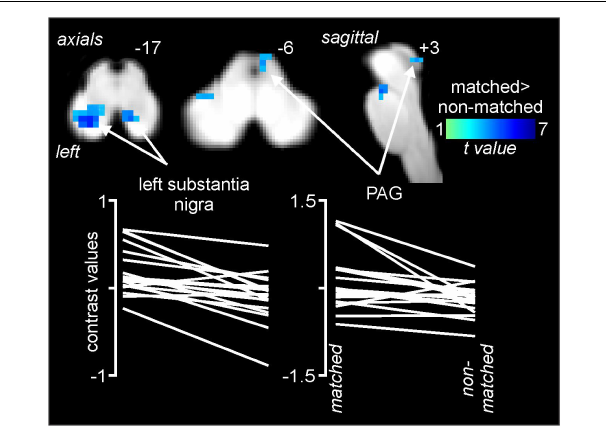
FIGURE 5 | Differences in signal intensity changes during painful stimuli during non-matched compared with matched expectation scans for the brainstem-specific analysis. Reduced signal intensity changes (cool color scale) occurred during the non-matched compared with matched scans in the region of the substantia nigra bilaterally and the right midbrain periaqueductal gray matter (PAG). Slice locations in Montreal Neurological Institute space are indicated at the top right of each image. The lower row are plots of contrast values for the left substantia nigra and right PAG for each subject during matched and non-matched expectation trials.